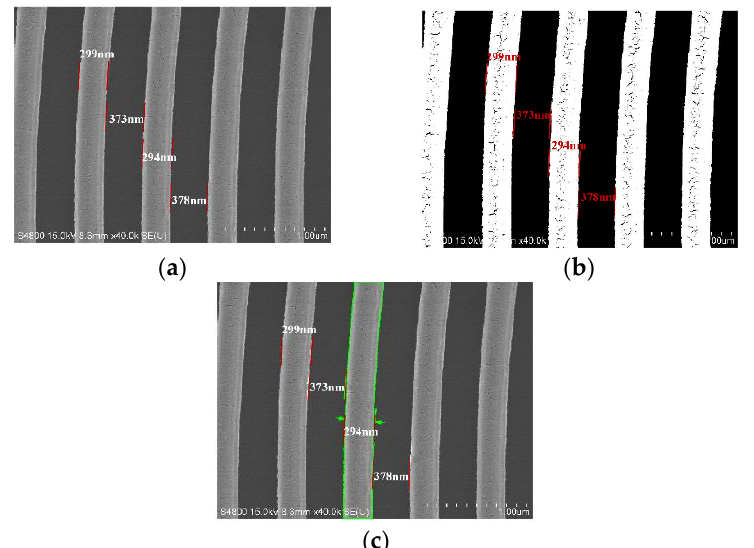
Figure 5. The boundary tracking after reactive ion etching. ( a ) original image; ( b ) binary image; and ( c ) Application results.